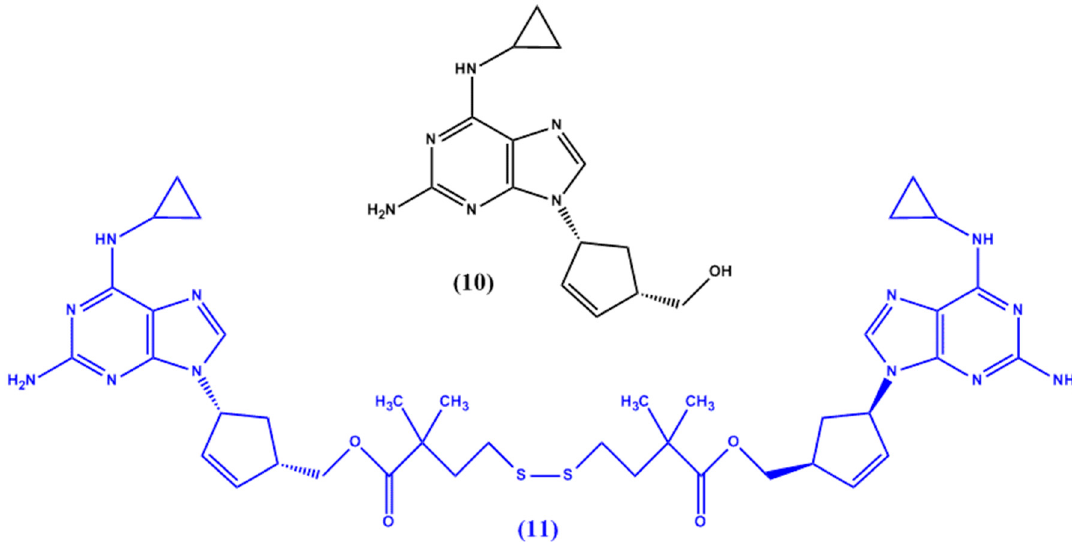
Figure 5. Chemical structures of abacavir ( 10 ) and its dimer prodrug 11 .